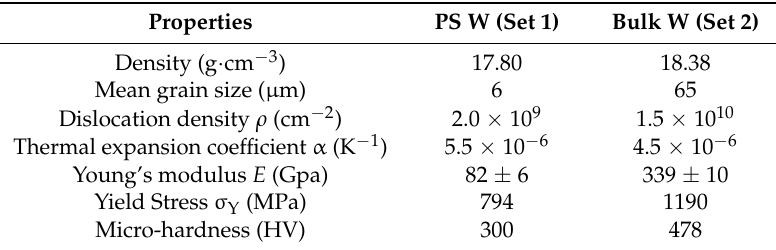
Table 2. Properties of PS and bulk tungsten